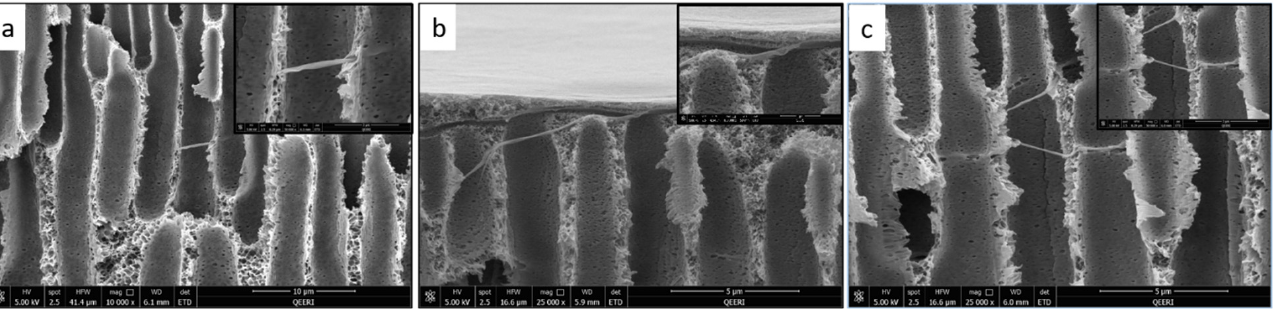
Figure 9. Illustration of the CNF in different SEM cross-section images for: ( a ) PSF/0.2 wt.% CNF (M3), ( b ) and ( c ) PSF/0.3 wt.% CNF (M4).